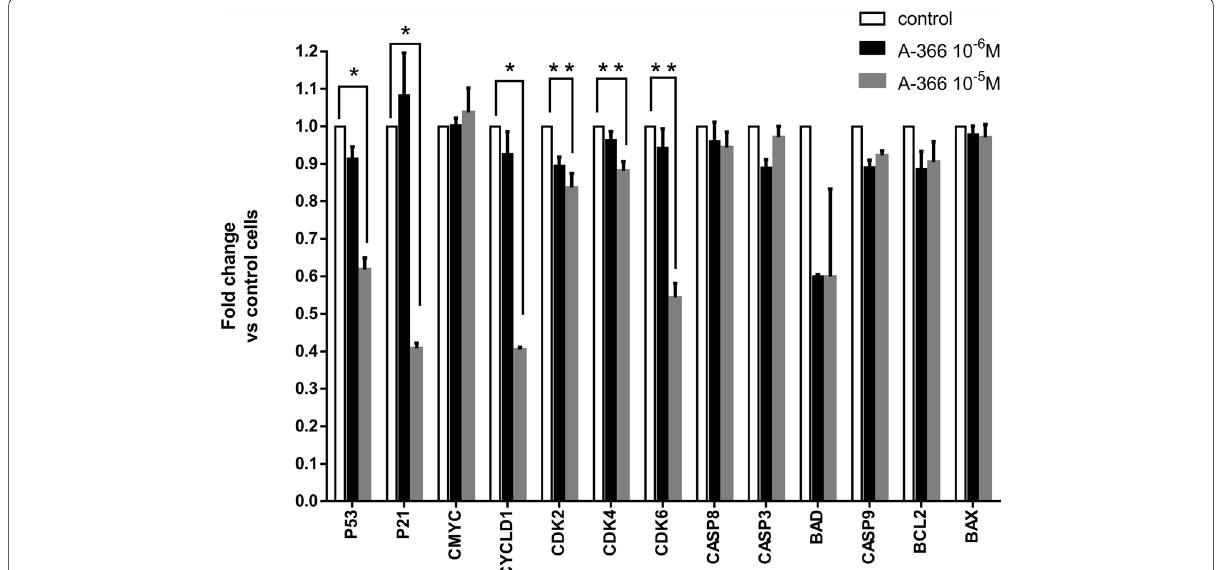
Fig. 5 Gene expression assessment by qPCR analysis of K562 cells treated with A-366. K-562 cells (10 5 cells ml − 1 ) were grown in the absence (control) of presence of A-366 at the concentration of 10 − 6 M or 10 − 5 M for 48 h. Total RNA isolation was followed by cDNA synthesis to allow qPCR analysis of the indicated genes, as shown under “Methods” section. * p < 0.01, ** p < 0.05; Student’s t-test. Data in the panel represent means standard ±